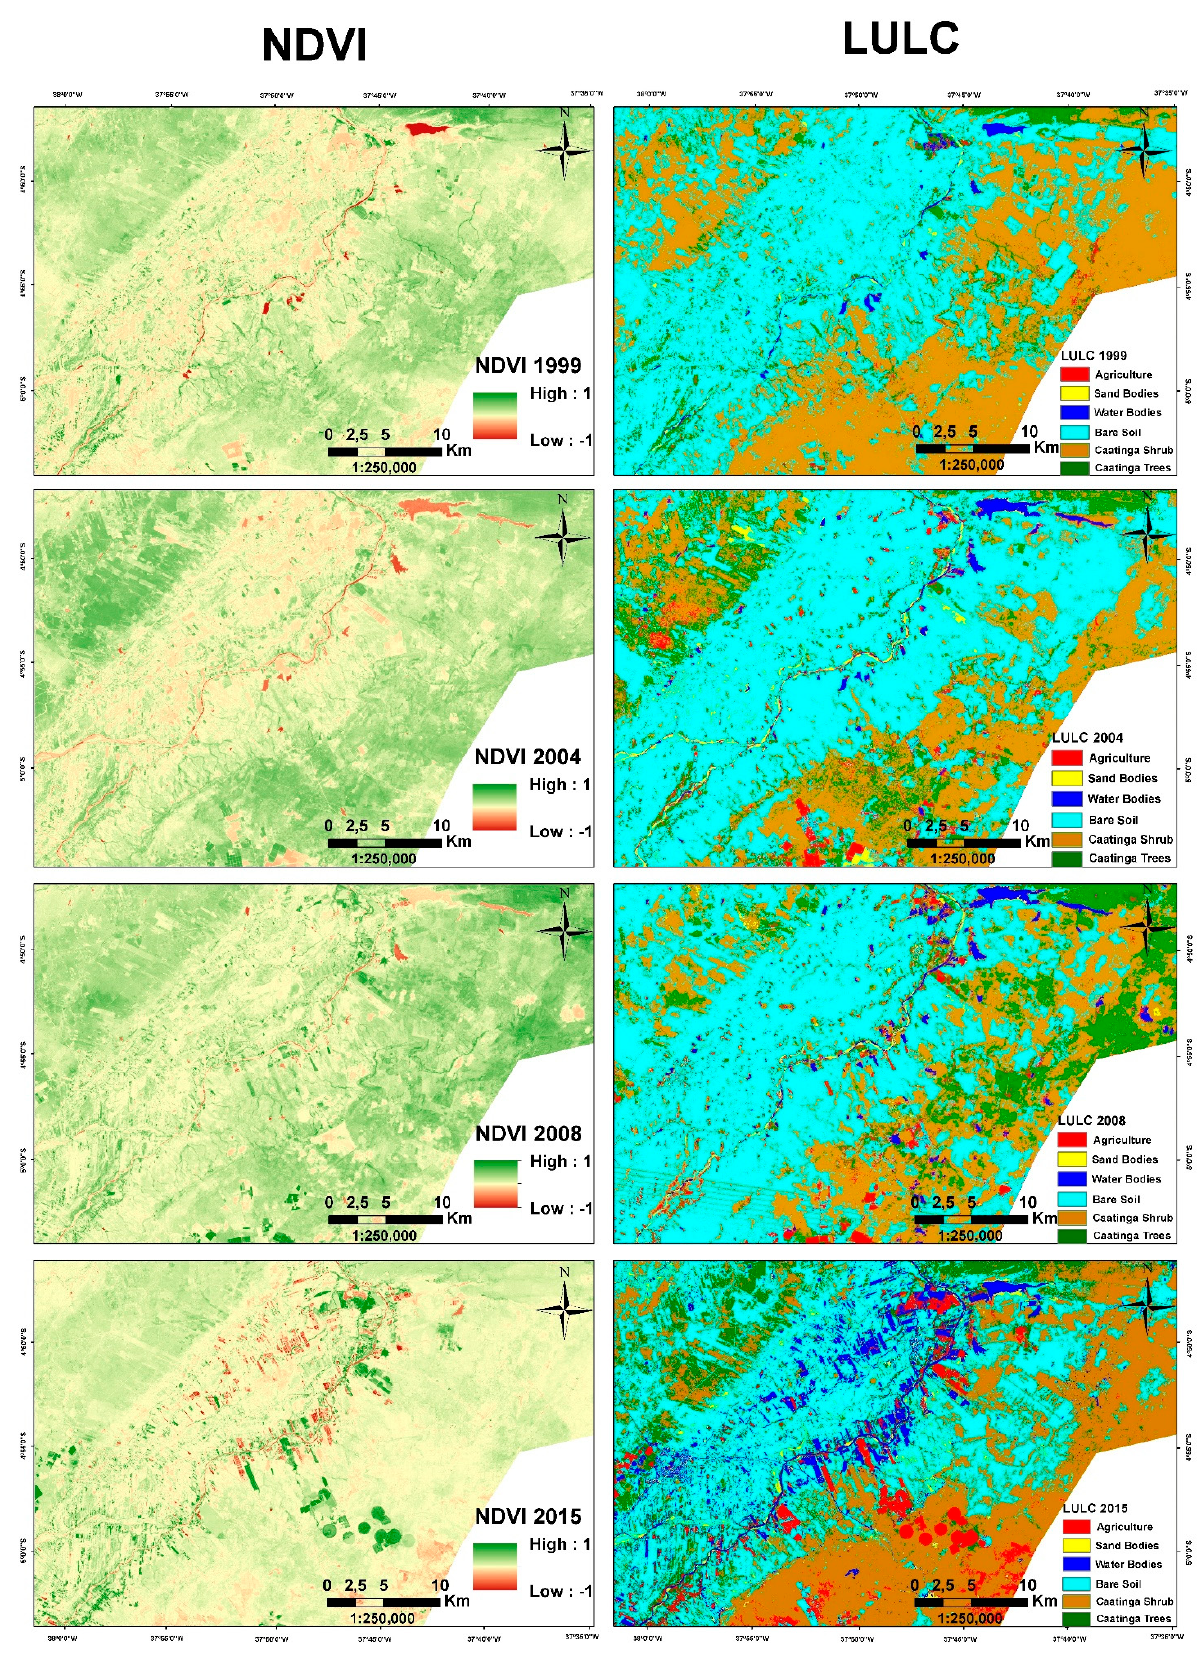
Figure 5. Land use and land cover and NDVI in the Jaguaribe River margins at the LJRSB for 1999, 2004, 2008, and